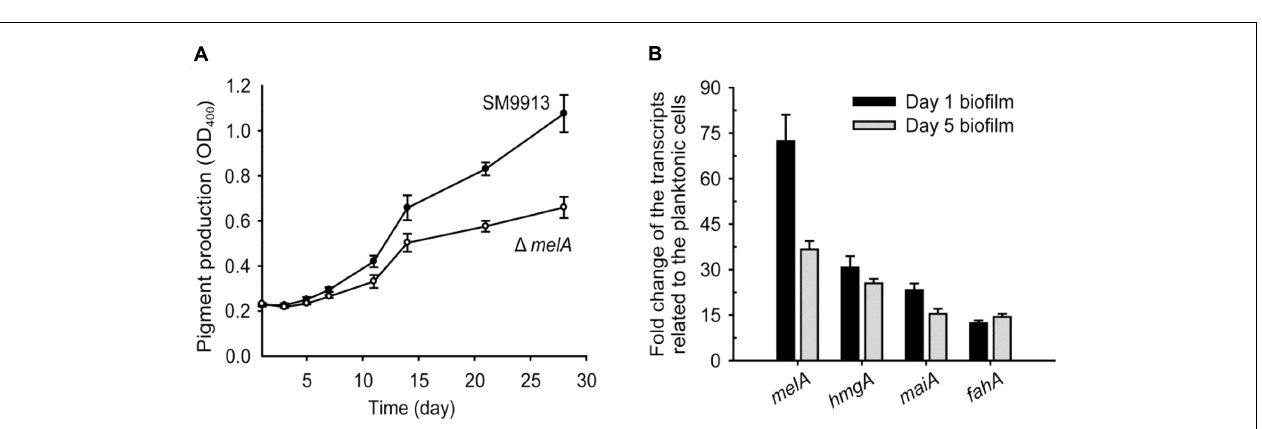
FIGURE 3 | Pyomelanin production is increased during biofilm formation. (A) Pigment production of SM9913 and (cid:49) melA strains were measured by OD 400 in static culture at 15 ◦ C in SWLB. (B) Fold changes of the melA , hmgA , maiA , and fahA transcription in biofilm cells (day 1 or day 5) compared to planktonic cells (OD 600 ∼ 1) in SWLB at 15 ◦ C. Data are the average of three independent cultures, and one standard deviation is shown in (A,B)